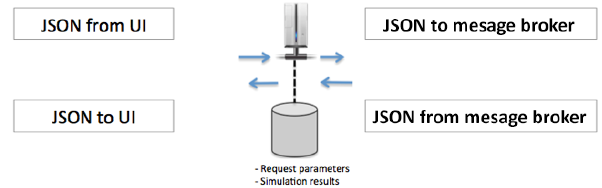
Figure 2. Message broker main functionalities are presented con- sisting of the exchange of messages between the SSA platform and the CDAM.